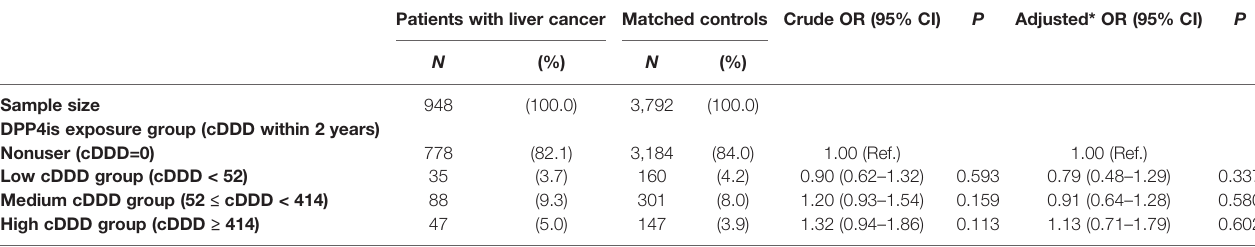
TABLE 2 | Association between DPP4is exposure and liver cancer risk among patients with T2DM receiving second-line therapy. Patients with liver cancer Matched controls Crude OR (95%